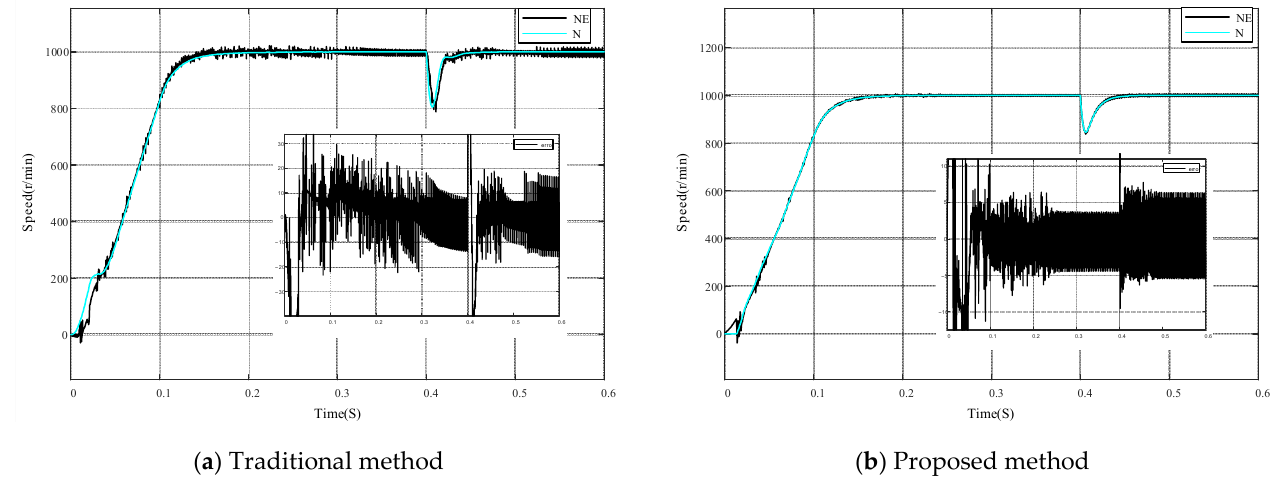
Figure 8. Actual speed and estimated speed waveforms when the load suddenly changes.